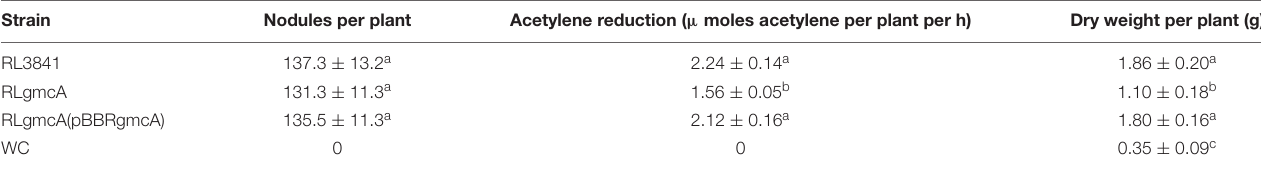
TABLE 4 | Symbiotic behavior of R. leguminosarum gmcA mutant. Strain Nodules per